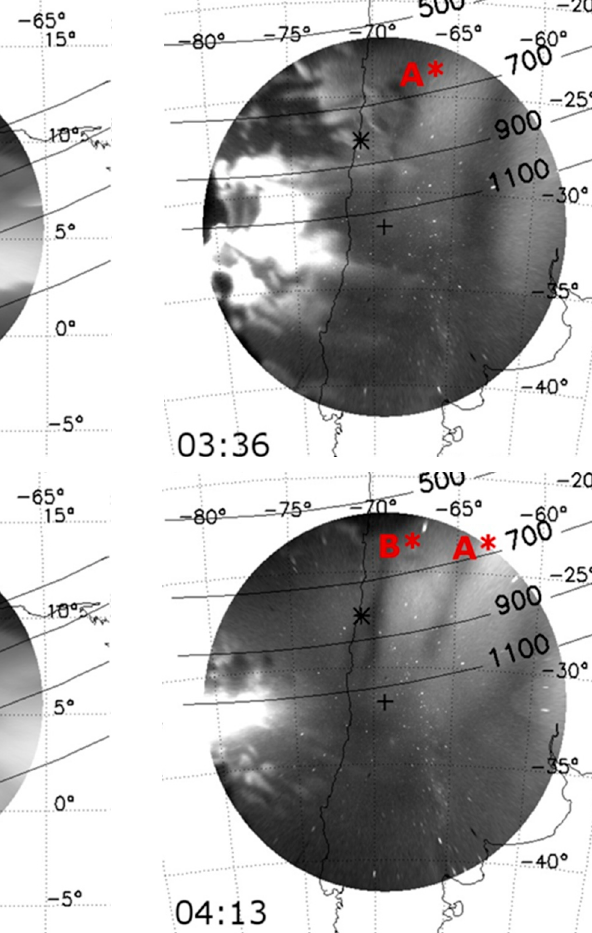
Figure 7. ( left ) Villa de Leyva unwarped images at 03:38 UT ( top ) and 04:13UT ( bottom ) using an emission height of 250 km. Eastward moving depletions labelled A, B, and C are indicated; ( right ) simultaneous images from El Leoncito, unwarped at 300 km, where the conjugate depletions are marked as A* and B*. While depletion C extends to almost 700 km apex height, depletion C* is not seen in the field of view of the El Leoncito imager.